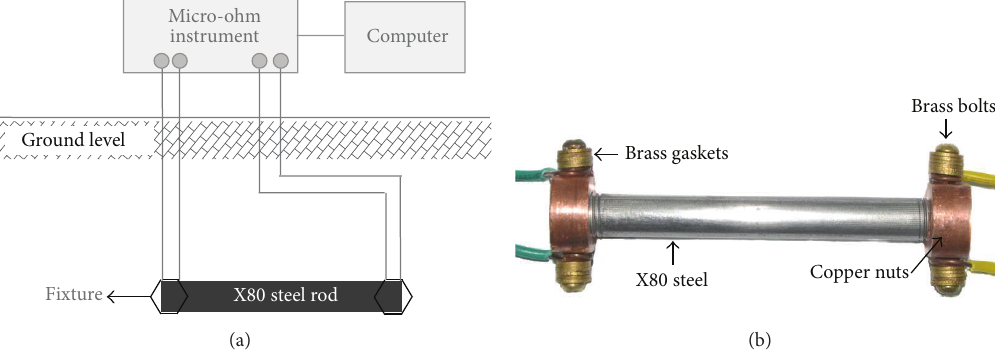
Figure 2: Schematic diagram of the electrical resistance test setup (a) and the photo of fixture (b) for clubbed X80 steel specimen in soil.